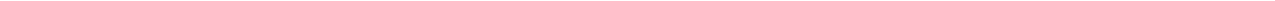
Figure 7 | FBXW2 mutants have the loss- or gain-of-function activity. ( a ) FBXW2 mutants have reduced binding with SCF components: H1299 cells were transfected with indicated plasmids, followed by G418 selection. Resistant clones were pooled and subjected to FLAG-bead IP and IB with indicated Abs. ( b , c ) FBXW2 mutants MU-S84C ( b ) and MU-E269K ( c ) are unable to shorten SKP2 protein half-life: Stable H1299 cells were incubated with CHX for indicated time periods and harvested for IB. The band density was quantified. ( d , e ) Loss- or gain-of-function of FBXW2 mutants: H1299 cells stably is mean ± s.e.m. Student’s t -test was performed, * P o 0.05; ** P o 0.01; *** P o 0.001. ( f , g ) FBXW2 mutants either lose the tumour suppressor function